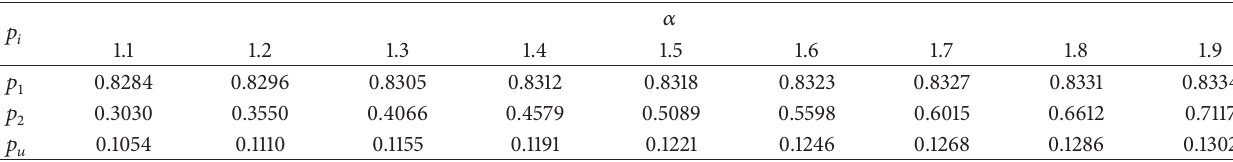
Table 1: Different price value for parameter 𝛼